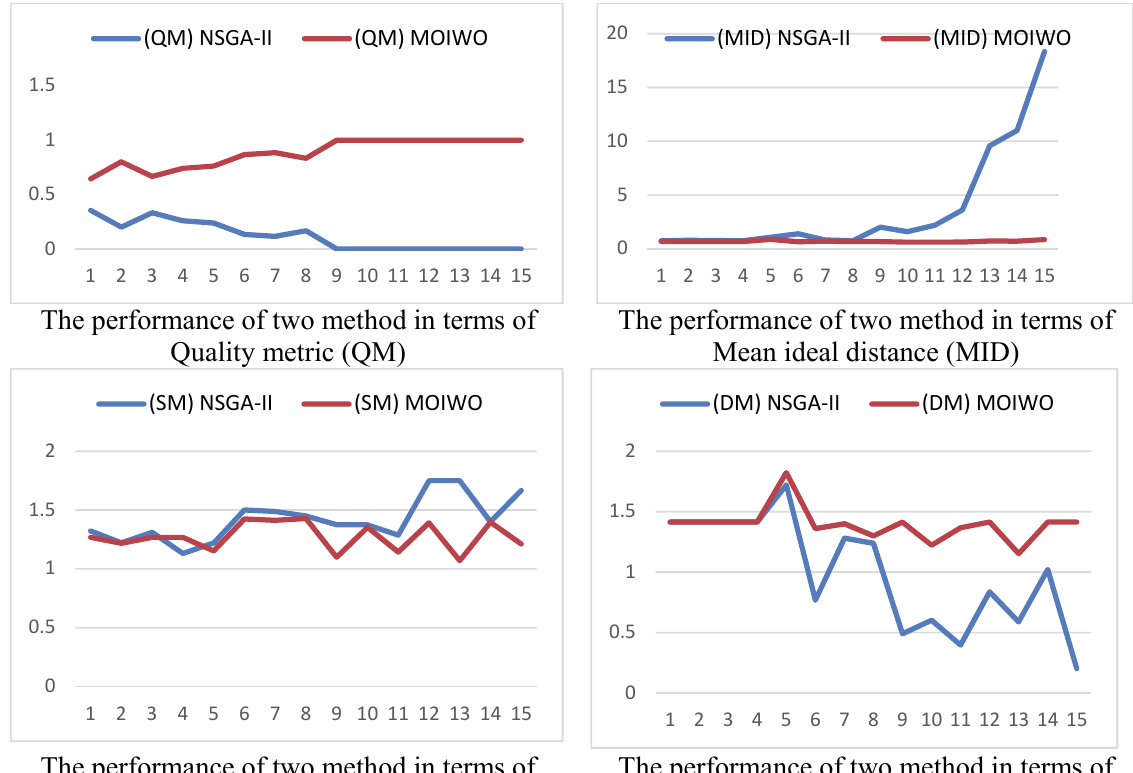
Fig. 1. The performance of NSGA II versus